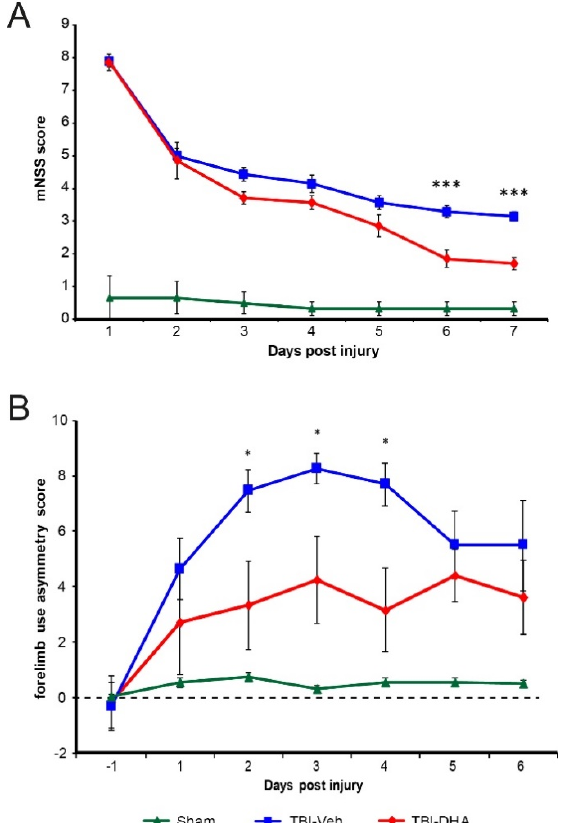
Figure 1. Docosahexaenoic acid (DHA)-treated traumatic brain injury TBI rats exhibited quicker and better recovery than the vehicle-treated TBI rats. ( A ) In the modified Neurological Severity Score (mNSS) test, DHA-treated rats (red diamond, n = 8) exhibited improvement in mNSS from day 3 post injury compared to the vehicle-treated TBI rats (blue square, n = 8). Sham-operated rats (green triangle, n = 7) exhibited limited deficit in the mNSS test throughout the 7 days of testing. ( B ) In the forelimb use asymmetry score test, DHA-treated TBI rats (red diamond, n = 8) exhibited improvement in mNSS from day 1 post injury compared to the vehicle-treated TBI rats (blue square, n = 8). Sham-operated rats (green triangle, n = 7) exhibited a limited di ff erence in forelimb use asymmetry score test throughout the 7 days of testing. The * and *** indicate p < 0.05 and p < 0.001, respectively.